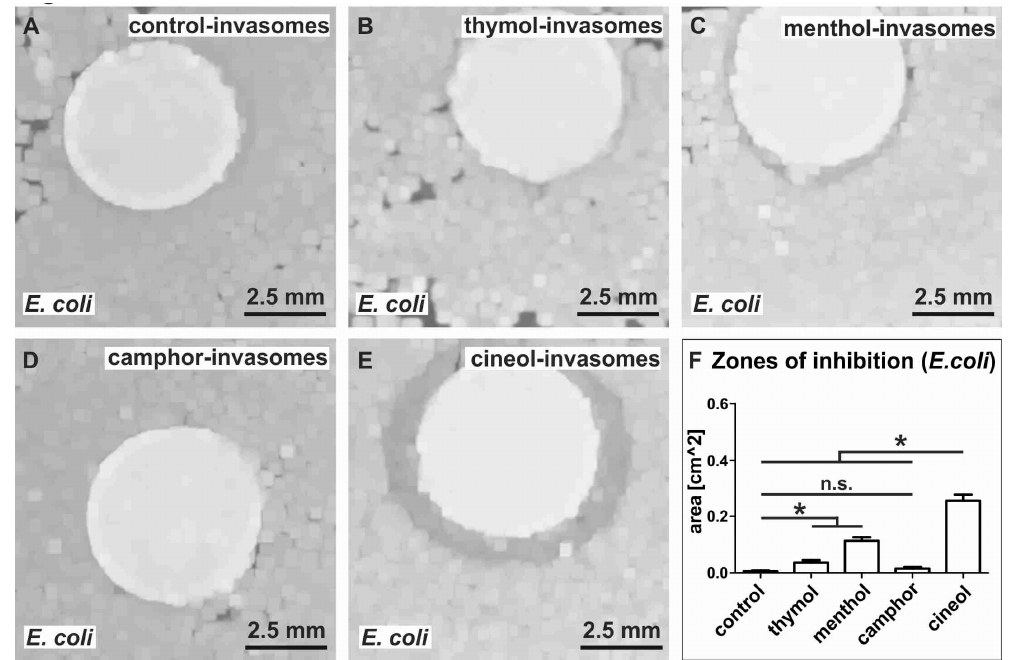
Figure 10. Invasomes encapsulating cineol reveal bactericidal activity against E. coli in a growth- inhibition zone assay. ( A , B ) Control invasomes without terpenoids or thymol invasomes did not affect bacterial growth. ( C,D ) While menthol-invasomes led to a slight inhibition of E. coli growth, camphor-invasomes did not affect growth of S. aureus. ( E ) Strong growth inhibition of E. coli exposed to invasomes comprising cineol. ( F ) Statistical evaluation of the measured zones of inhibition validated the significant inhibition of E. coli growth by cineol-containing invasomes compared to all other terpenoid-invasomes and control. * p < 0.05 was considered significant (Mann–Whitney test, one-tailed). (n.s. means not significant)